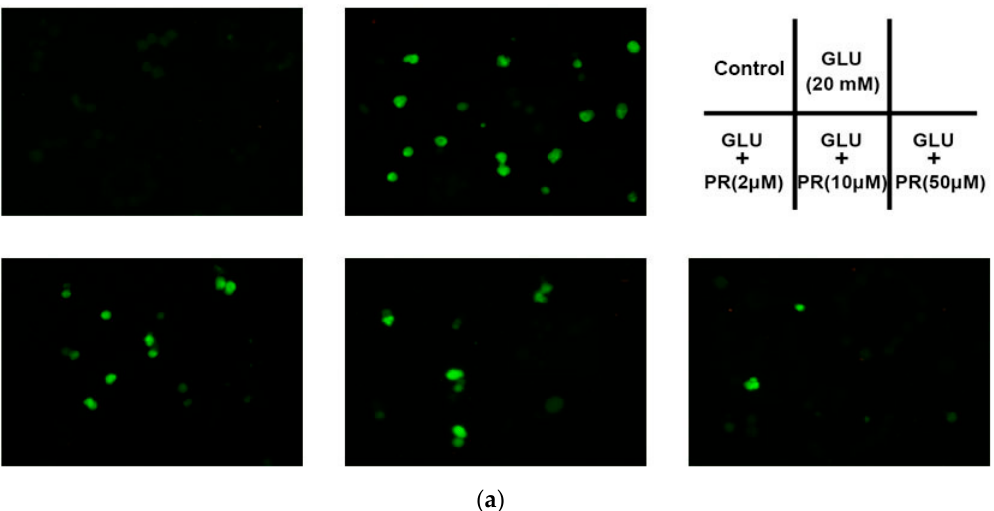
Figure 3. Cont. Figure 3. Cont.